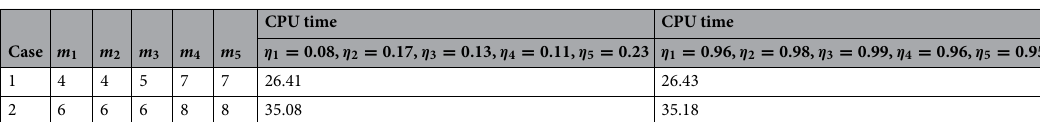
Table 4. The runtime (in seconds) of the proposed method with different choices of m i , i = 1, 2, 3, 4, 5 , for Example 2.